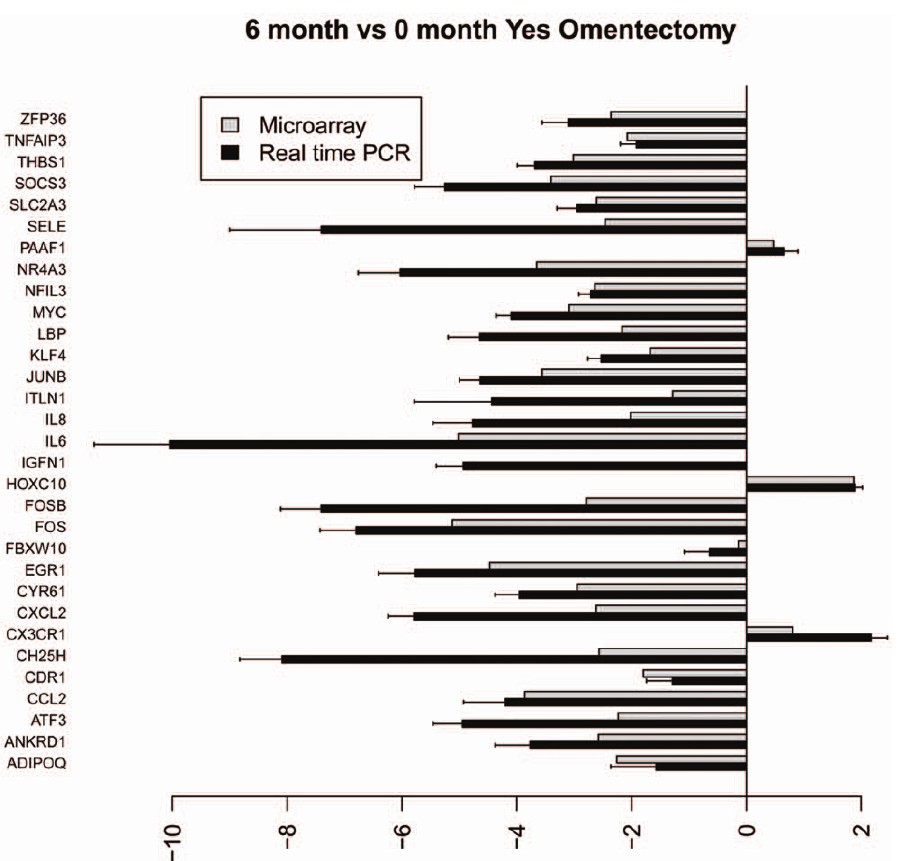
Figure 6. Bar graph illustrating the fold change of individual genes at 6 vs. 0 months with omentectomy as determined by microarray (grey) and TLDA profiling (black).